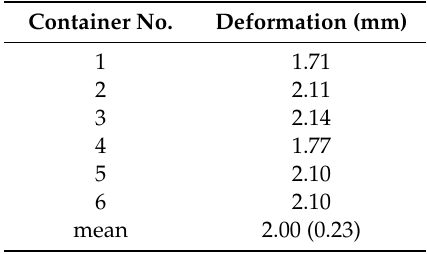
Table 4. Flexural strength of the